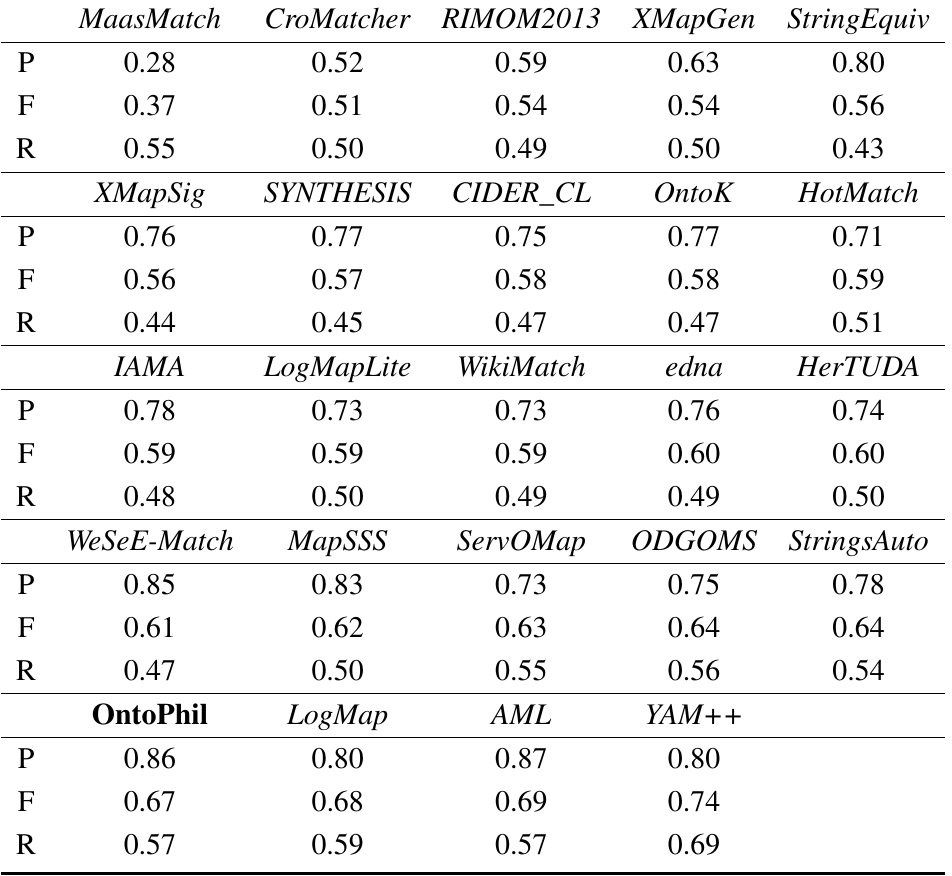
Table 2. Results obtained in the OAEI-13 conference track compared with OntoPhil (ordered by